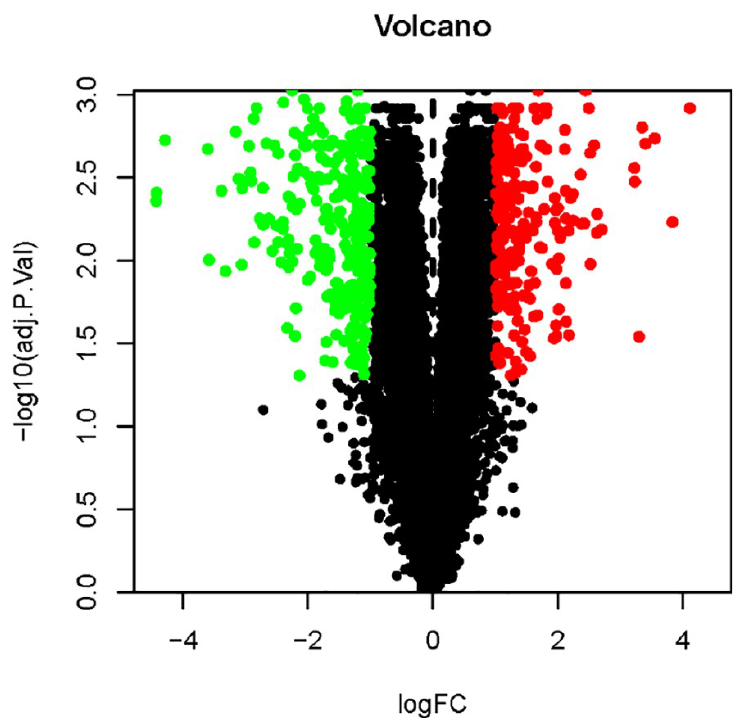
Fig 2. Volcano map of differentially expressed genes. The red and the green dots represent DEGs that were significantly upregulated (genes) and downregulated (genes), respectively (adjusted p-value < 0.05, and |logic| > 1).